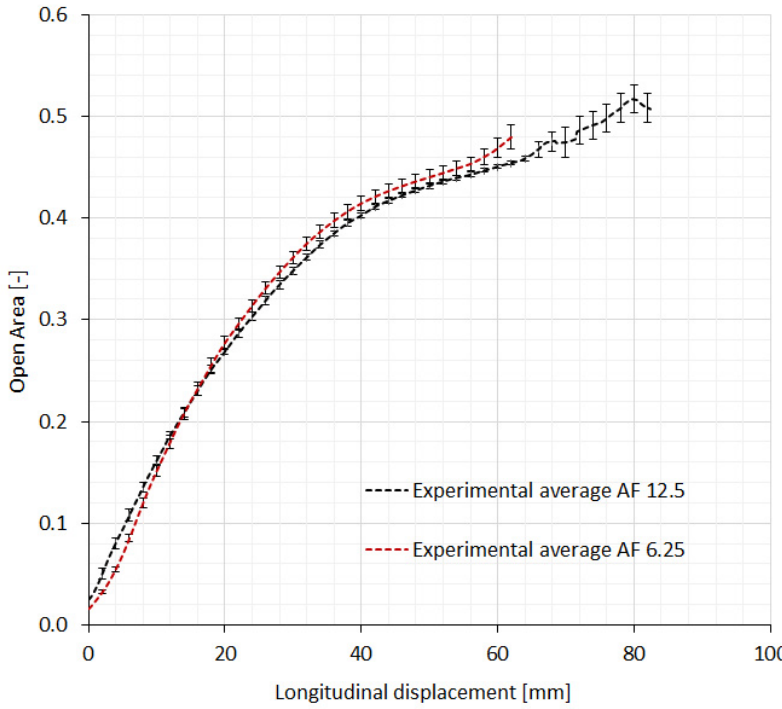
Figure 7. The relationship between the open area and longitudinal displacement.